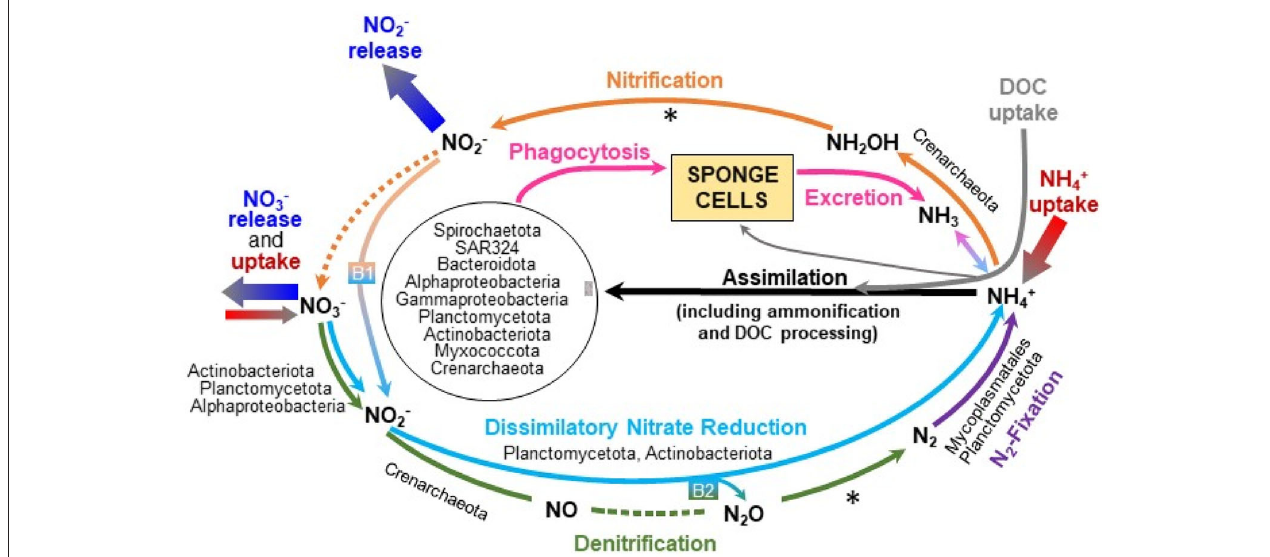
FIGURE 6 | Graphical summary of the microbiome-driven nitrogen cycle in Vazella pourtalesii, as it has been deduced through the metagenomic study and the incubation experiments. Note that only those N pathways for which MAGs were found to be enriched in the sponge are named in the graph. The dashed lines indicate enzymatic pathways for which genes were not detected and the asterisk (*) indicates genes that were present only in the unbinned data. “B1” and “B2” refer to putative bridges between major biochemical pathways, which provide alternative routes to palliate the effects of some missing enzymes, also allowing an efficient closing of the N cycle in the holobiont. The N microbial engine of V. pourtalesii appears to revolve around the incorporation of ammonium from the seawater and its internal recycling. This nutrient fosters N assimilation by the sponge microbiota, which also benefits from the important amounts of DOC taken up by the sponge. All available evidence suggests that the nourishment of V. pourtalesii does not appear to be based on filter feeding of the free-living bacterioplankton but rather on the phagocytosis of its internal microbiota, which is mostly farmed in the bacteriosyncytia through the supply of ammonium and